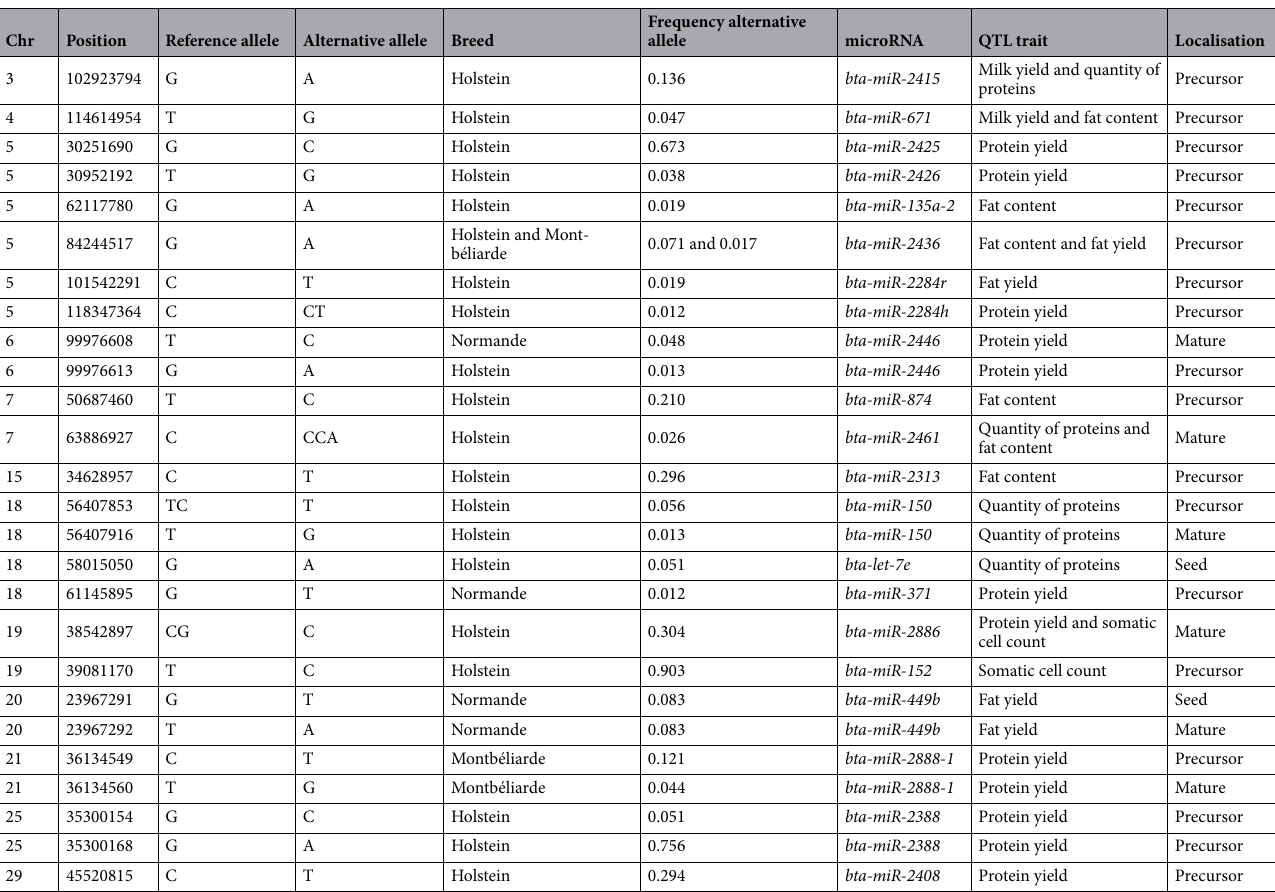
Table 3. Description of the 26 genetic variants detected in the precursor of microRNAs in bovine QTL regions.